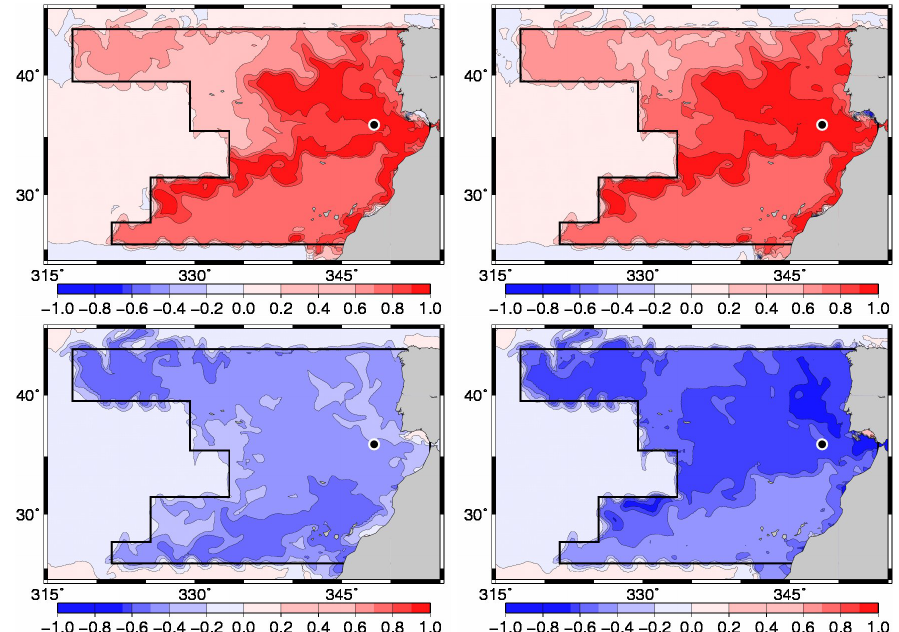
Fig. 9. Phytoplankton (top panels) and nitrate (bottom panels) horizontal correlation structure with respect to phytoplankton at 11.7 ◦ W 36 ◦ N (North Atlantic), without anamorphosis (left panels), and after local anamorphosis transformations (right panels).